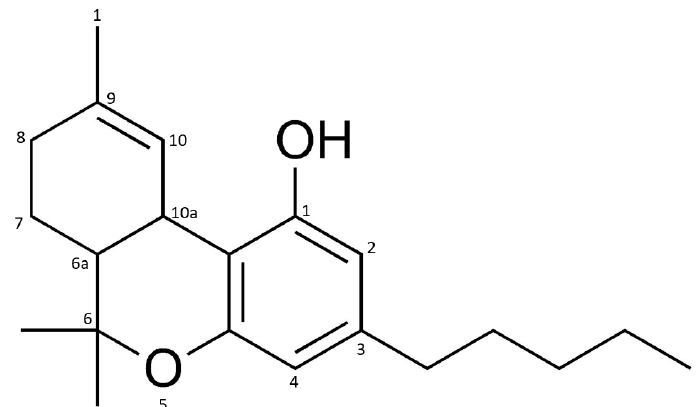
Figure 1. Chemical structure of ∆ 9 -tetrahydrocannabinol ( ∆ 9 -THC). There are currently no uniform EU maximum levels available for ∆ 9 -THC in